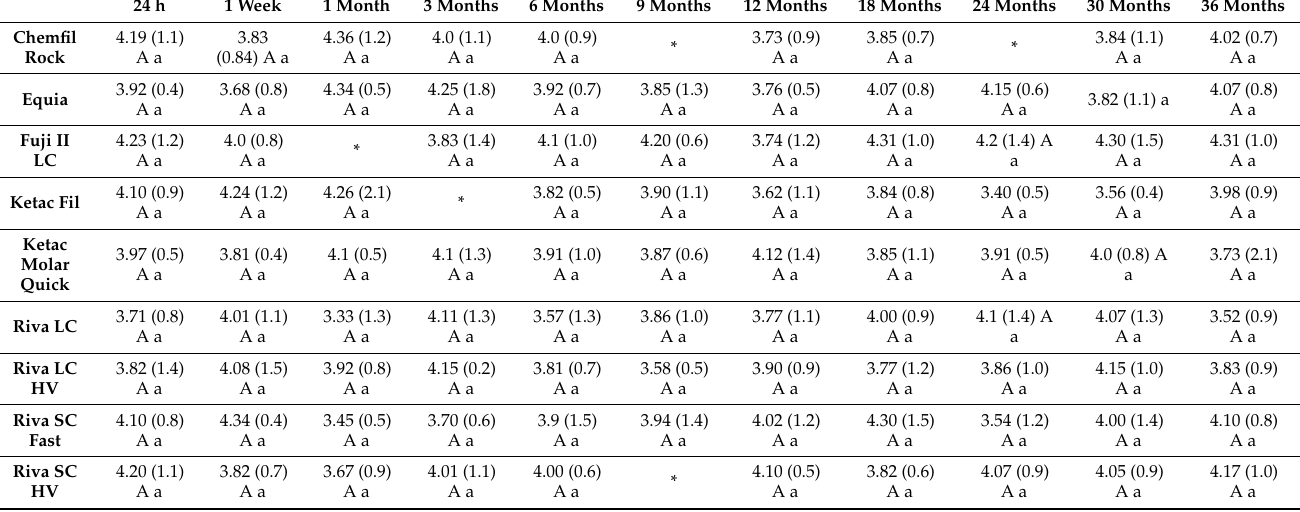
Table 5. Mean Bound Water Enthalpy